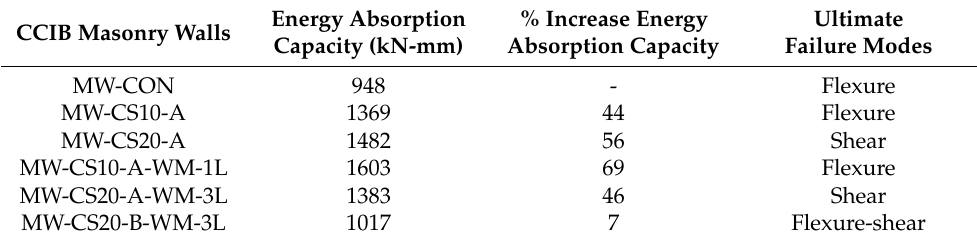
Table 4. Energy absorption capacity of the CCIB masonry walls.